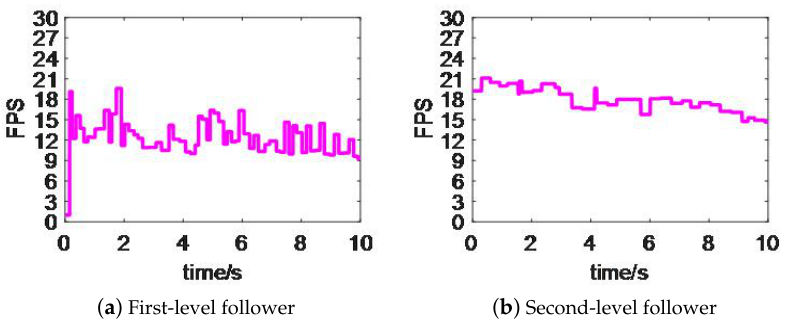
Figure 26. Frame rate measured by the vision of the first-level follower robot and the second-level follower robot over